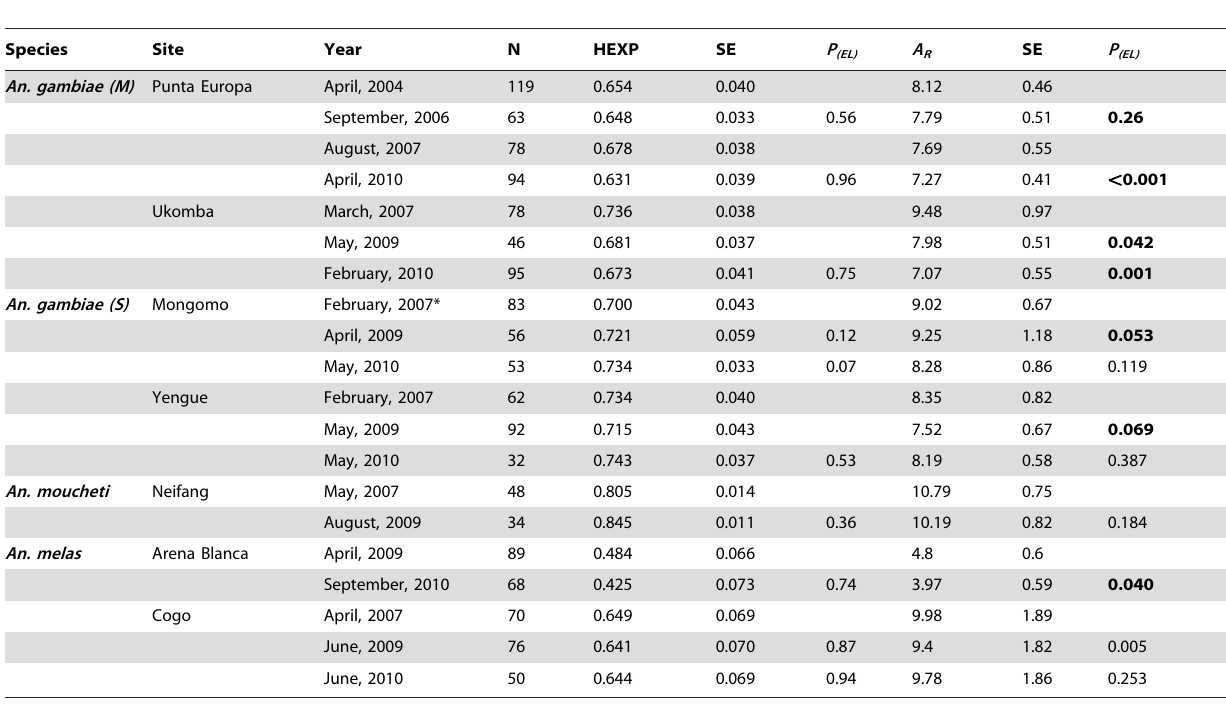
Table 2. Summary of heterozyosity estimates ( H E ) and Allelic Richness ( A R ) for all sampled species, populations, time points, including standard errors (SE).